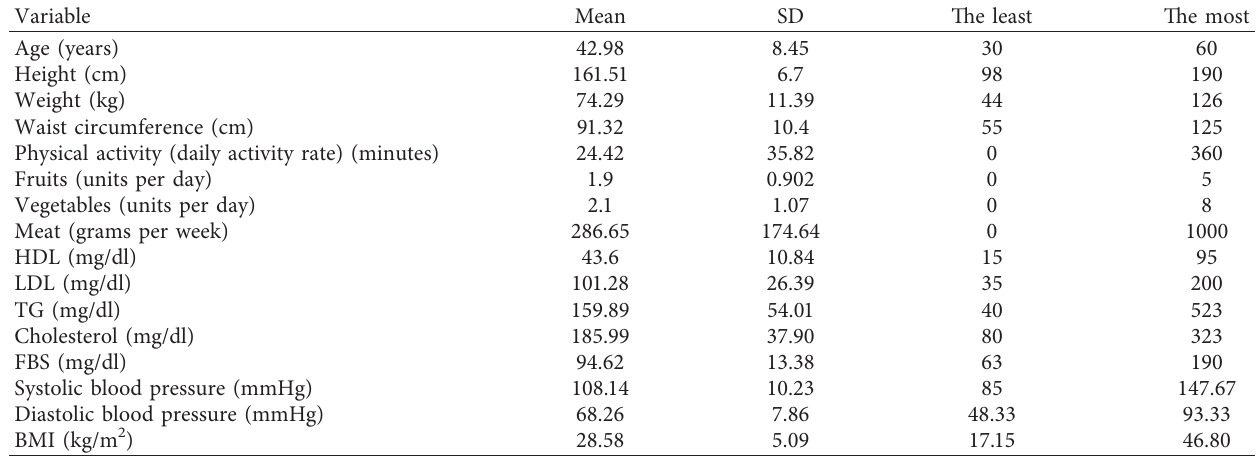
Table 3: The mean and standard deviation of quantitative variables.